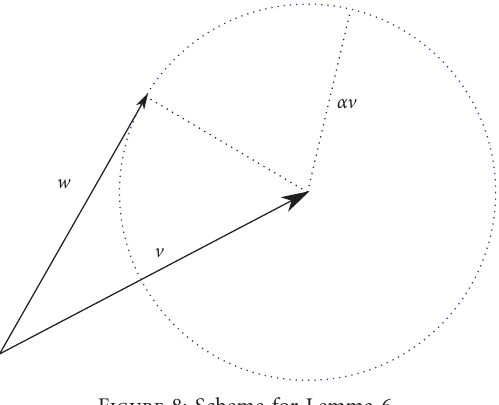
Figure 8: Scheme for Lemma